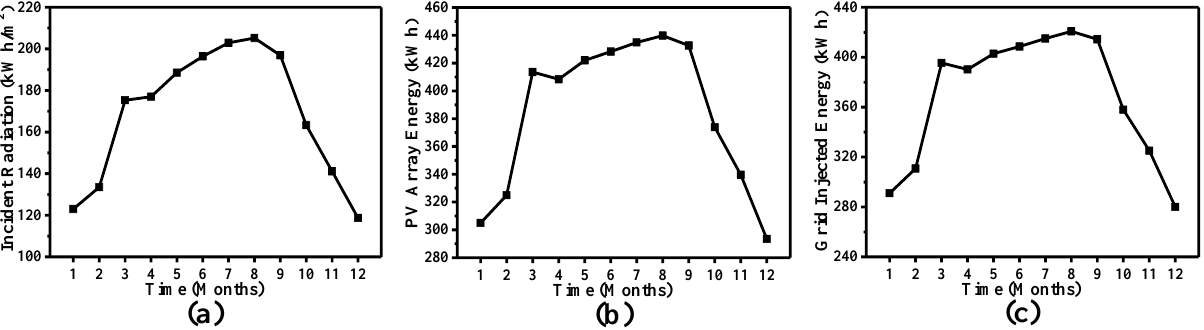
Figure 7: [Facade-T(30), A(0)] Configuration: (a) incident radiation received by the module surface, (b) generated energy by the array, and (c) energy injected to the